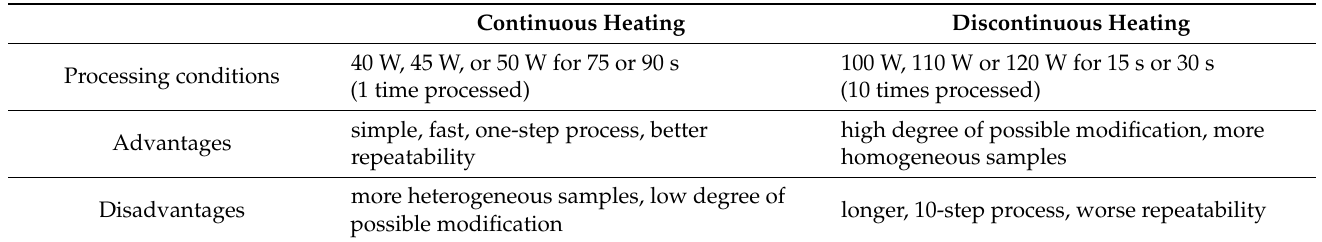
Table 5. Microwave irradiation